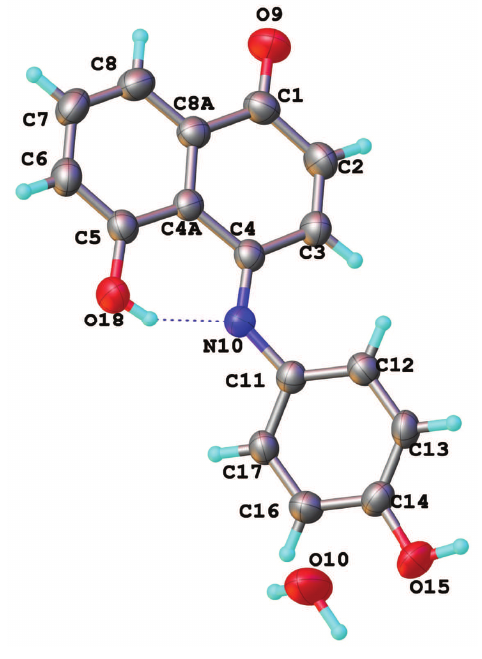
Table 1: Data collection and handling.